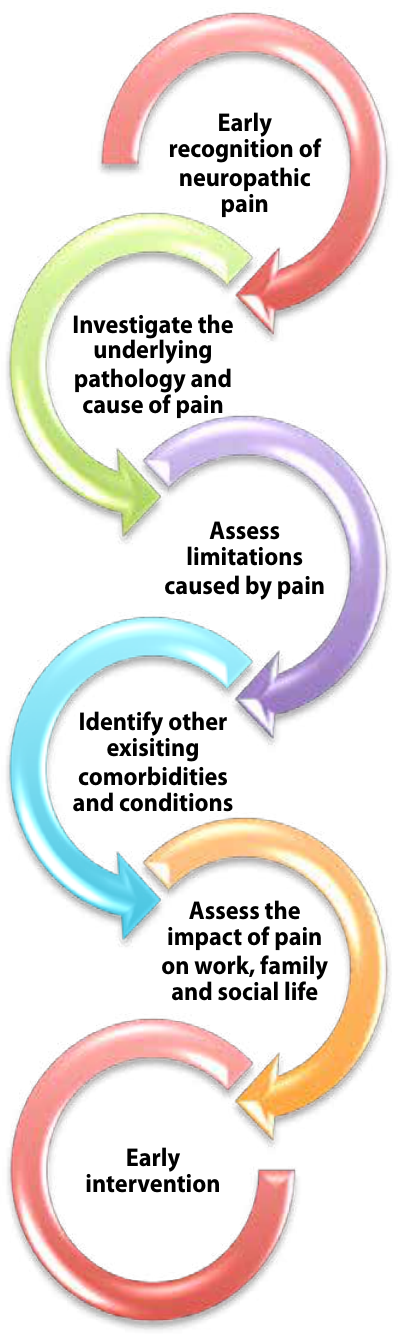
Figure 1: Diagnosis of neuropathic pain